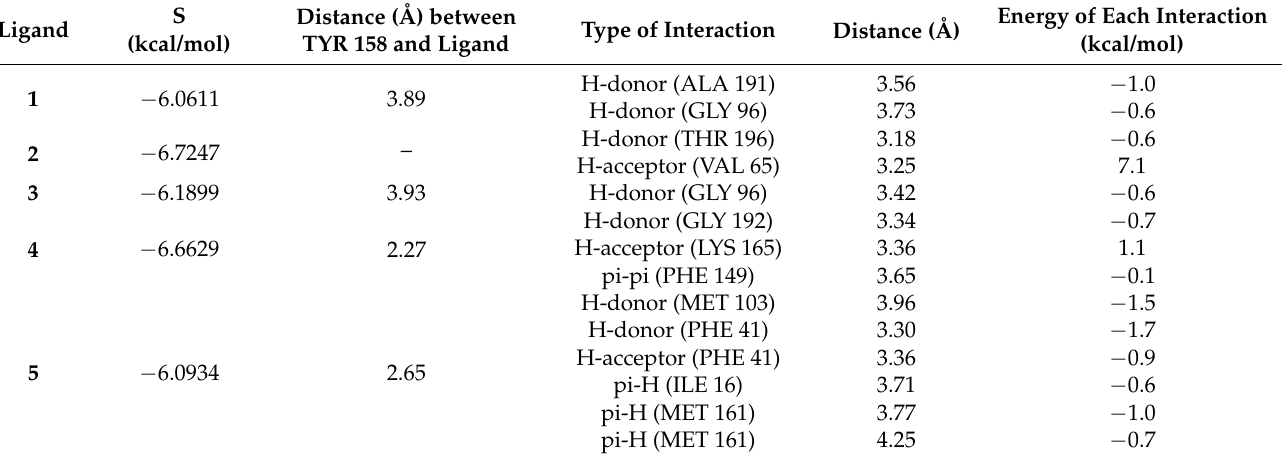
Table 3. Docking results of 2 – 10 docked into enoyl